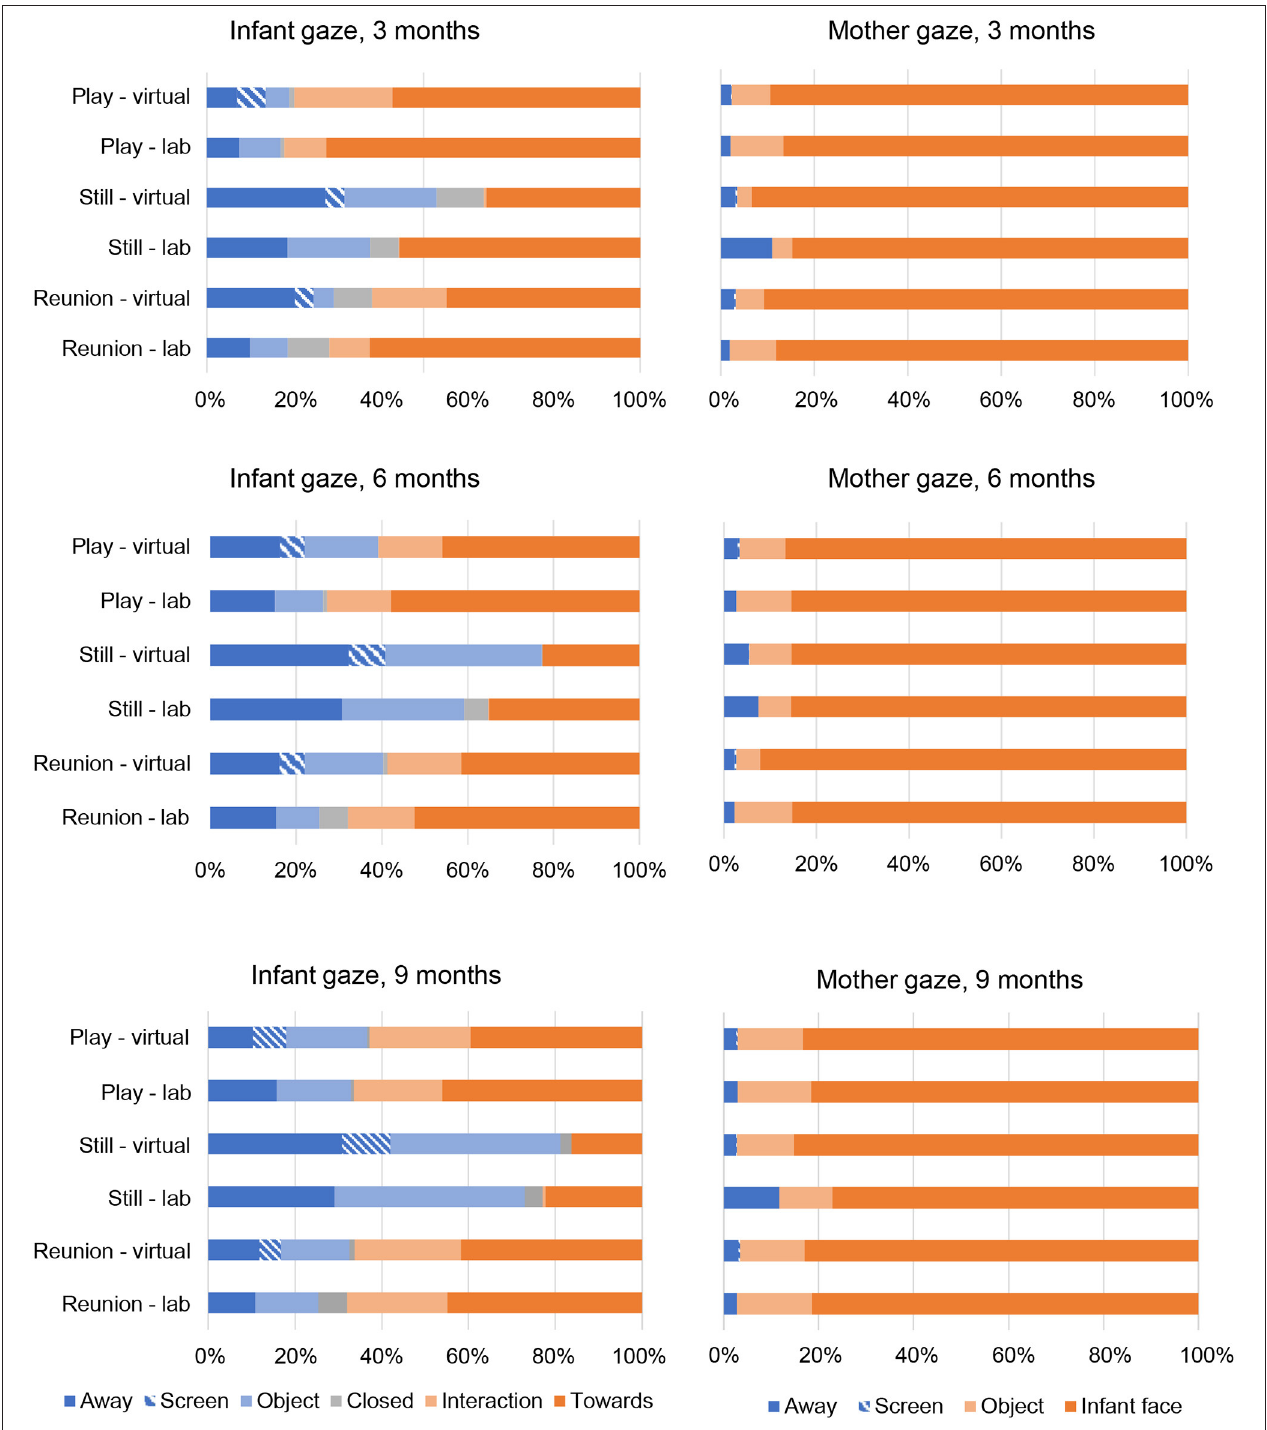
FIGURE 3 | Infant and mother gaze by Still Face episode, visit type and time point.